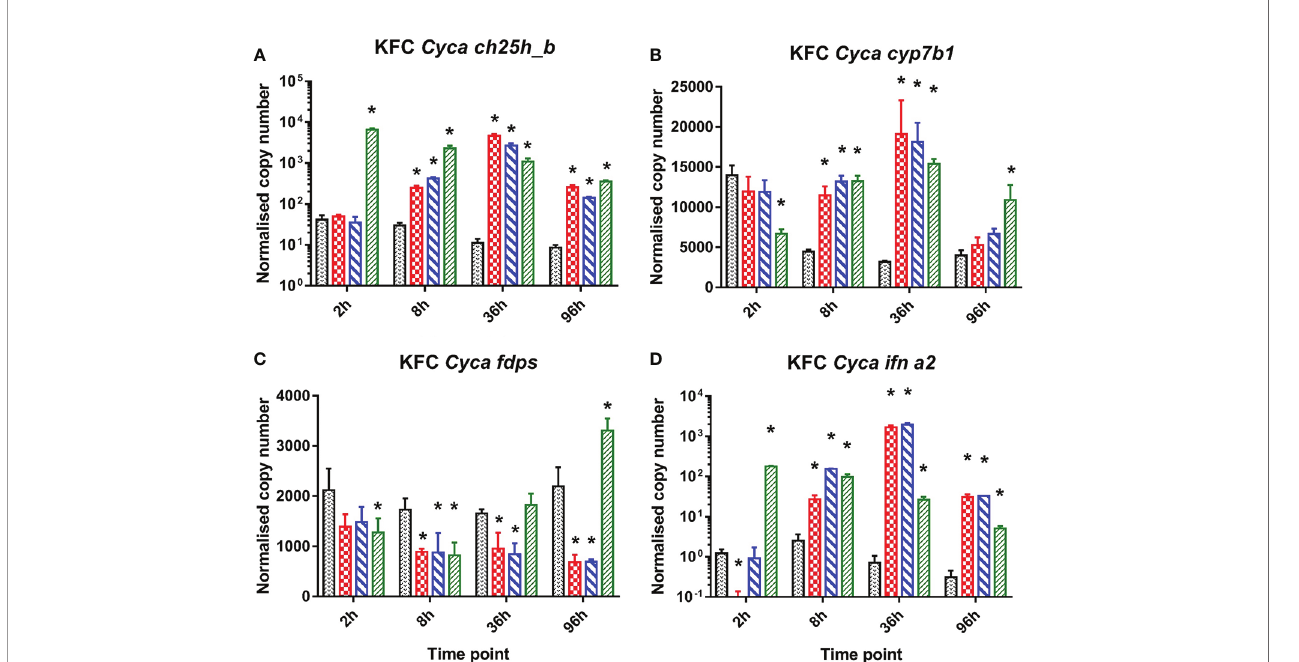
FIGURE 1 | Induction of mRNA encoding enzymes key to oxysterol metabolism and of INFa2 by synthetic analogues to B-form dsDNA, Z-form ds DNA, and dsRNA (poly I:C) as ligand to cytosolic sensors of DNA or dsRNA. Analysis of mRNA encoding for common carp ( Cyca ): (A) cholesterol 25 hydroxylase ( ch25h_b ), the enzyme involved in generating 25-hydroxycholesterol from cholesterol, (B) cytochrome P450 family 7 subfamily b member 1 cyp7b1 the enzyme involved in generating 7 a ,25diHC and (C) farnesyl diphosphate synthase ( fdps ), a key enzyme in the sterol pathway, (D) IFN a2 ( ifna2 ). Data presented as a bar indicating mean normalized copy numbers (+SD) from n = 3 replicates. * indicates the statistically signi fi cant difference at p<0.05 between control and stimulated cells. Analysis was performed with two-way ANOVA with treatments and time points as factors. The ANOVA was followed by subsequent pairwise multiple comparisons using the Holm-Sidak